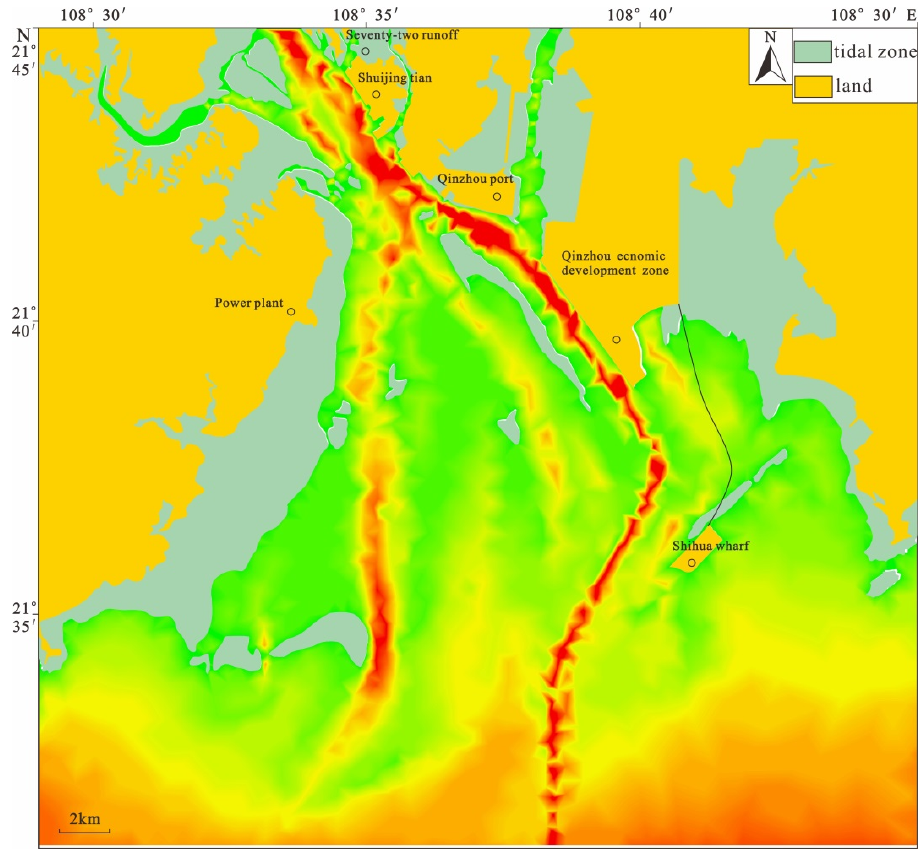
Figure 3. Bathymetric data and water depth in the research area.